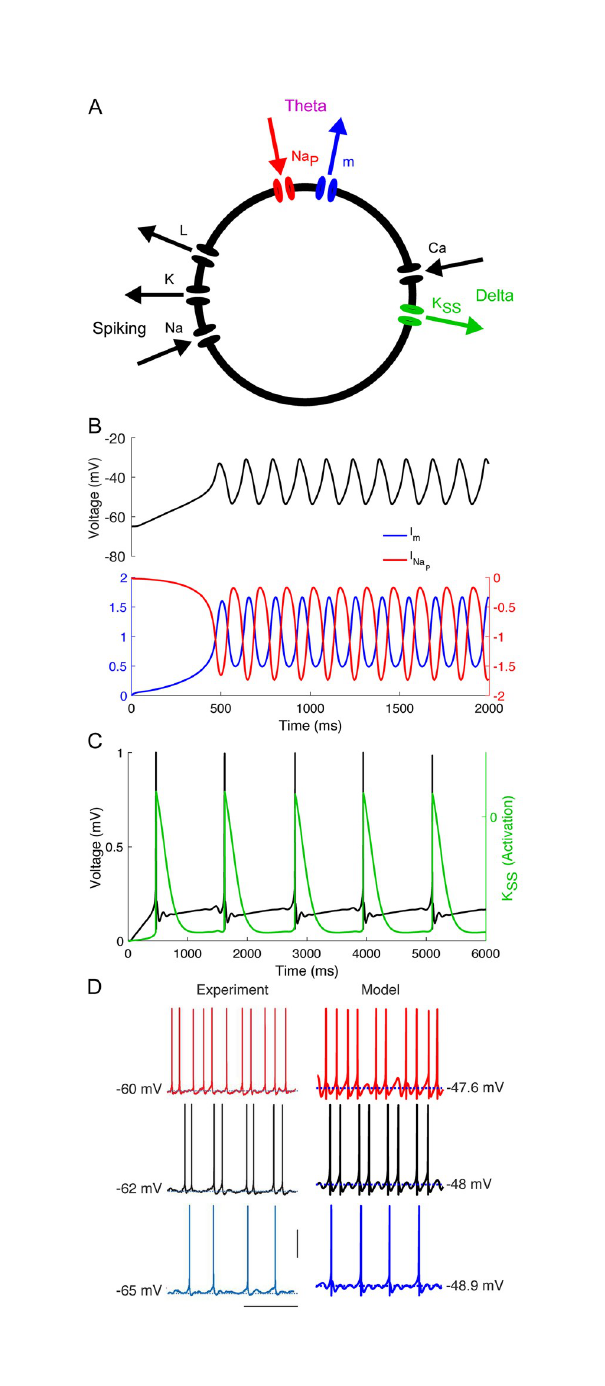
Fig 2. Model MS reproduces in vitro data. (A) Diagram of model MS. Arrows indicate directions of currents (i.e., inward or outward). (B) θ timescale STOs arise from interactions between m- and persistent sodium currents in a model without spiking or Ca -dependent currents (only g m and g nonzero). (C) δ timescale activity-dependent Na P hyperpolarization arises from a super-slow K current. (D) Comparison between in vitro (adapted from [50]) and model data (vertical bar 50 μ V, horizontal bar 0.5 ms).